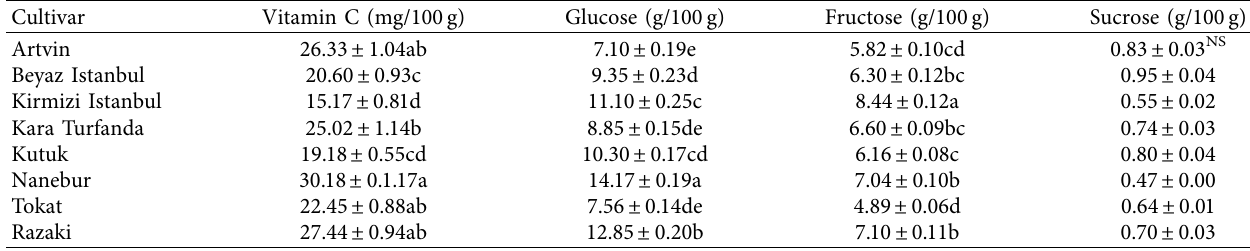
Different letters in the same column indicate statistically significant differences ( p < 0 . 05). Table 6: Total carotenoids, total flavonoids, and % inhibition level of grape cultivars. Cultivar